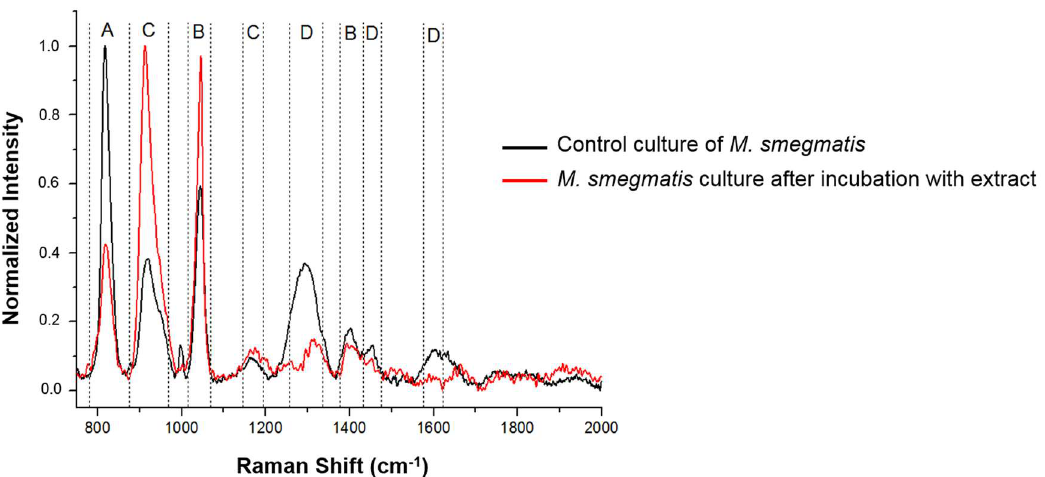
Figure 8. SERS spectra of cell wall surfaces of control M. smegmatis cells and cells incubated with the S. hermaphrodita protein seed extract at a concentration of 150 µg/mL for 6 days. The letters refer to signals characteristic of: A—nucleic acids, B—proteins, C—carbohydrates, D—lipids.